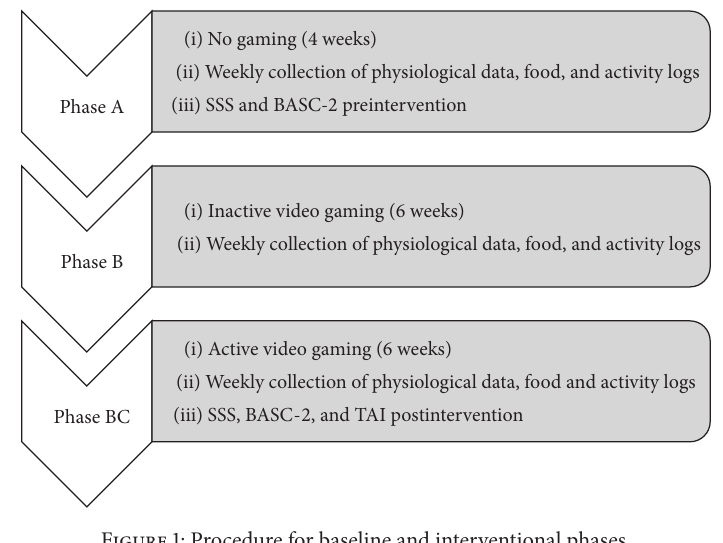
Figure 1: Procedure for baseline and interventional phases.